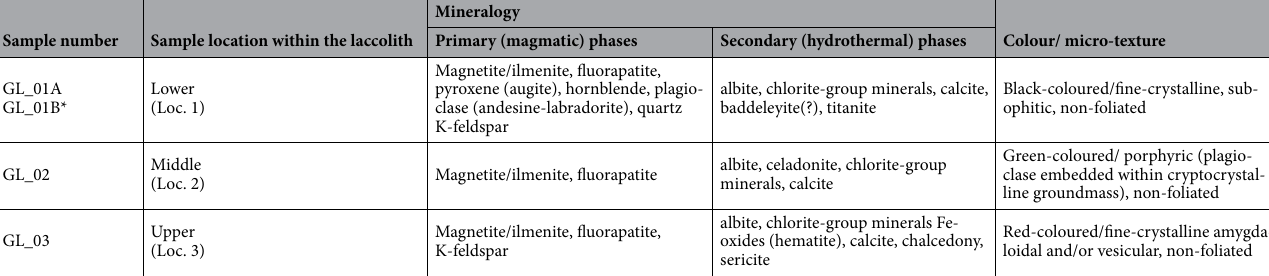
Table 1. Mineralogical and micro-textural description of the four samples types (GL_01A, GL_01B, GL_2, GL_03), which has been distinguished on the basis of alteration style and degree (i.e. chloritization and albitization) and collected from various (i.e. lower—Loc. 1, middle—Loc. 2, and upper—Loc. 3) regions of Głuszyca trachyandesite laccolith. *Note the samples GL_01A and GL_01B were distinguished due to variable albitization and chloritization degree. The former were marked by partial albitization of primary plagioclases and partial chloritization of primary pyroxenes, whereas the latter revealed partial albitization and pervasive